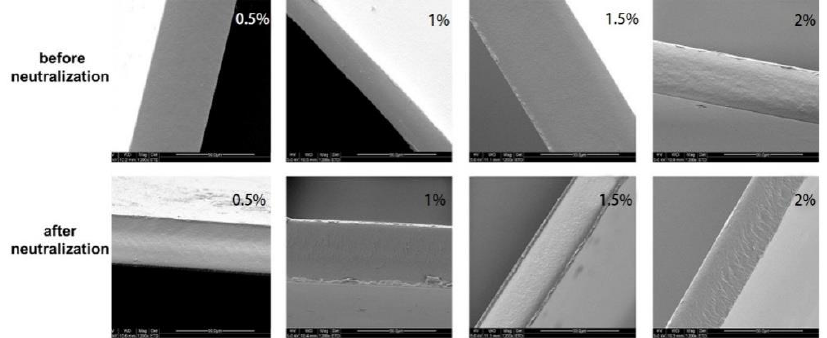
Figure 7. Effects of chitosan concentration on the microstructures of films before and after neutralization.